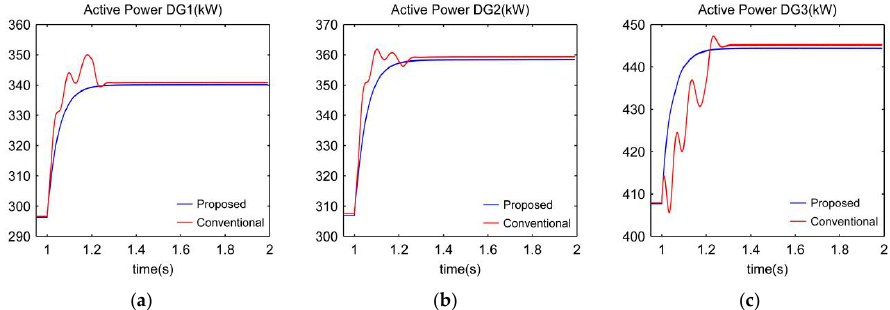
Figure 18. Power sharing of DG’s in load impact condition using proposed supplementary control compare with conventional droop controller ( a ) DG1; ( b ) DG2; and ( c ) DG3.